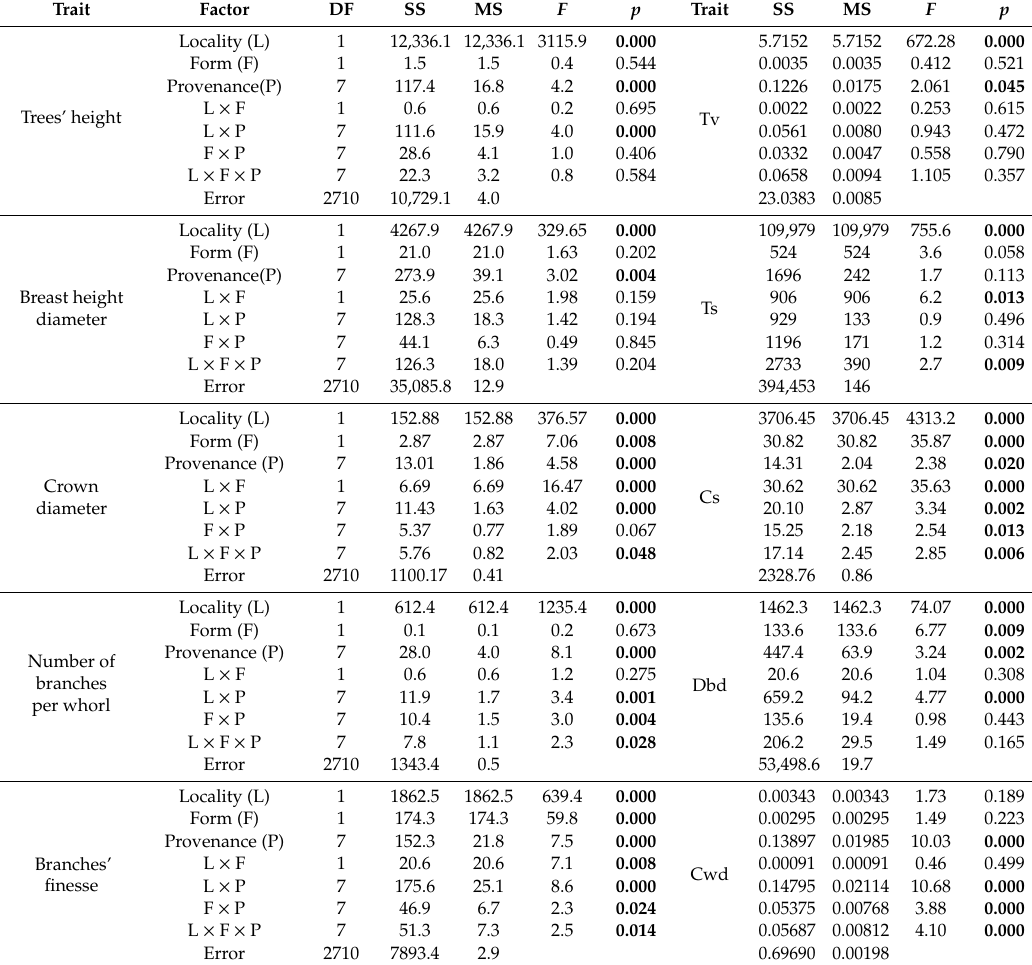
Figure 2. Distribution of family groups for trees’ height in the M ă neciu ( left ) and Soveja ( right ) trials. The first homogeneous group (most important for the breeding programme) is composed by the first three groups of collared families. Significant differences were registered between red and green groups, blue and the last two families groups (P7 and N7 in M ă neciu, N4 and P4 in Soveja) and orange toward the last one families group (N7 and P4 in M ă neciu and Soveja, respectively). Table 3. Influence of testing site, provenance and crown form of Norway